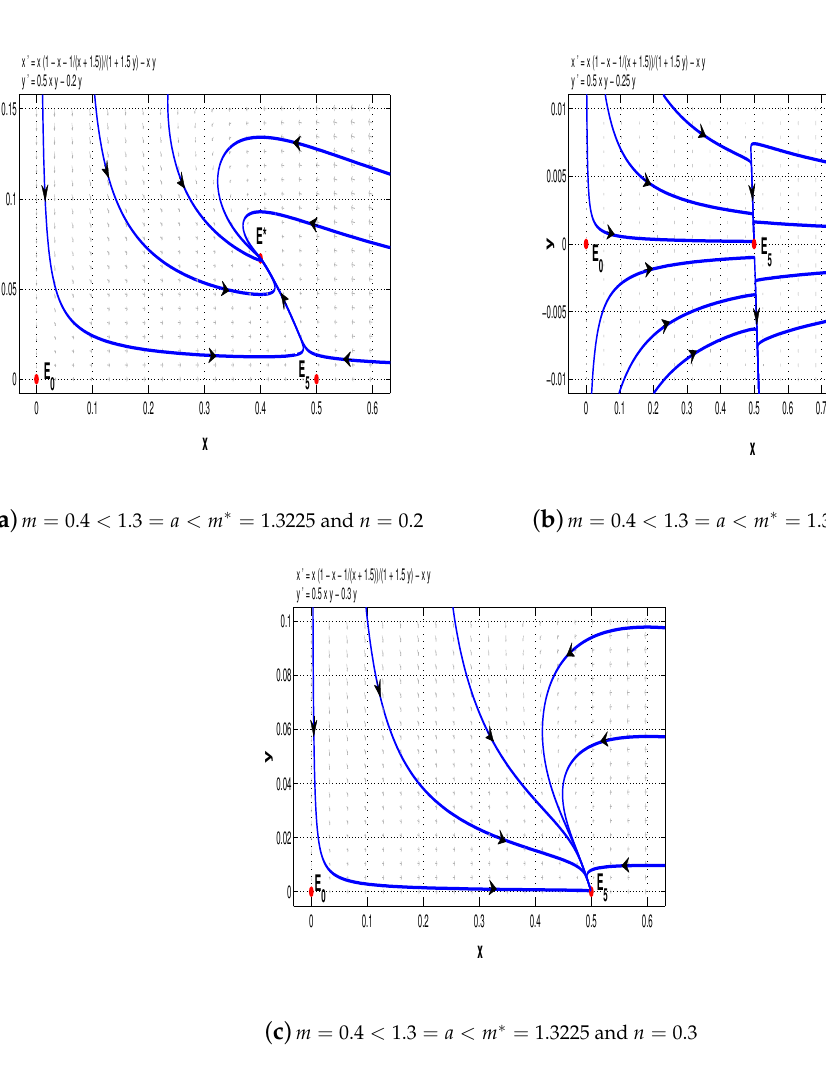
Figure 10. ( a ) When m = 0.4 < 1.3 = a < m ∗ = 1.3225 and n = 0.2, both E 0 and E 5 are saddle points and E ∗ is a stable node. ( b ) When m = 0.4 < 1.3 = a < m ∗ = 1.3225 and n = 0.25, E 0 is a saddle point and E 5 is a saddle-node. ( c ) When m = 0.4 < 1.3 = a < m ∗ = 1.3225 and n = 0.3, E 0 is a saddle point and E 5 is a stable